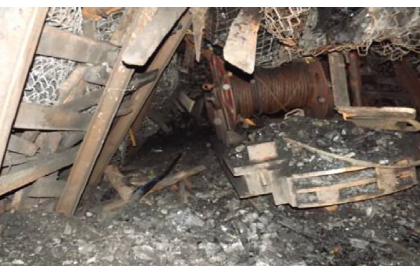
Figure 5: Picture of haulage roadway failure caused by rockburst.